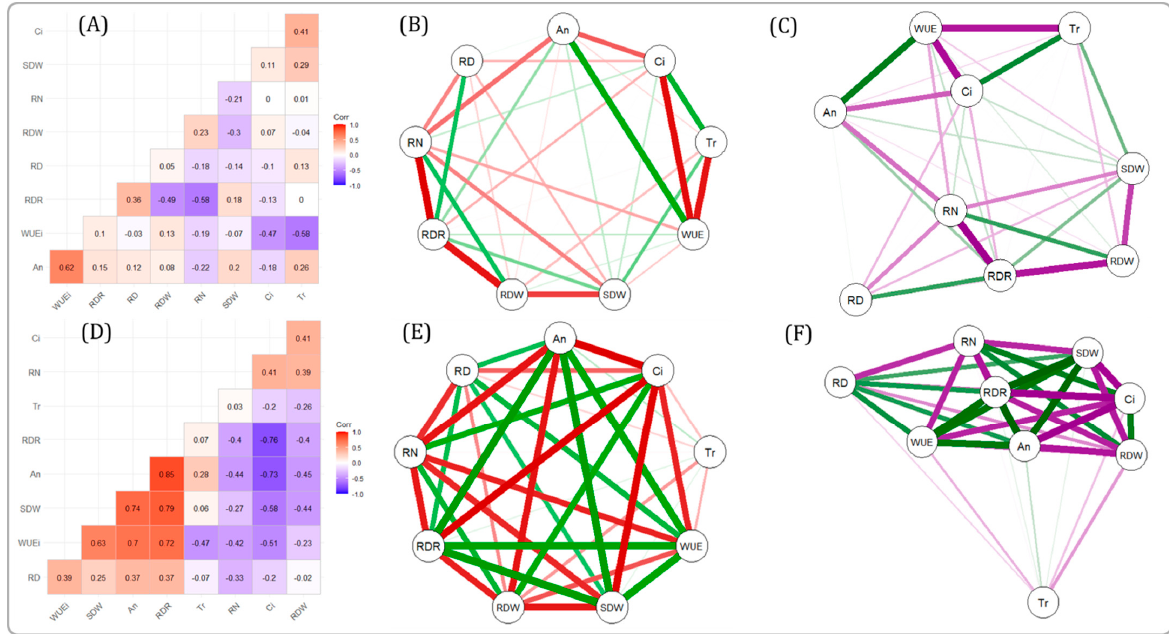
Figure 2. Pairwise Pearson phenotypic correlation and network of morpho-physiological traits. The correlation ( A , D ) and network ( B , C , F ) of the nine traits evaluated in rice plants under well-watered (WW) ( A – C ) and drought stress (DS) ( D – F ) conditions. The width of the lines represents the strength of the correlation and the color of the lines represents the nature of the correlation. The red and the purple lines represent negative correlation and the green line represents positive correlation. 2.5. Instantaneous WUE (WUEi) Is Correlated with the Ratio of Deep Rooting and Biomass Accumulation Instantaneous WUE is the ratio of photosynthetic rate to transpiration rate. High WUEi results from a higher photosynthetic rate with the same transpiration rate, the same photosynthetic rate with a low transpiration rate, or both. To analyze the factors that con- tribute more to WUEi, both transpiration rate and photosynthetic rate were regressed against WUEi (Figure 3). WUEi was strongly associated with photosynthesis (r = 0.701 **) and transpiration rate (r = − 0.484 **) under drought conditions. This suggests that higher photosynthetic rates and lower transpiration rates contribute to higher WUEi. A higher photosynthetic rate is considered an indicator of high biomass accumulation that leads to higher WUEi, which is evident from the strong positive correlation of WUEi with shoot biomass accumulation (r = 0.634 **). At the same time, RDR showed a strong positive cor- relation with WUEi (r = 0.708 **) and shoot biomass (r = 0.788 **), thus indicating that deep- rooted genotypes efficiently use water to produce higher biomass under drought (Figure 3A,B). Further, the genotypes with high RDR had a lower decrease in shoot dry weight, which is an indicator of drought tolerance. For instance, traditional landraces AC 36738, AC 35729, AC 35717, AC 36762, AC 36735, and Moroberekan exhibited >30% RDR with a minimum reduction in SDW, ranging from 12.1% to 28.1%.